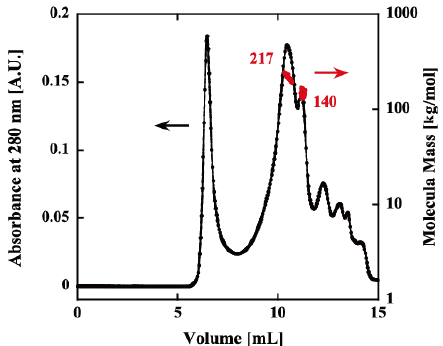
Figure 2. Size exclusion chromatography–multiangle light scattering (SEC-MALS) of rPfPV1-Strep. The refolded protein was analyzed using an SEC column (KW-804SQ). Chromatograms display